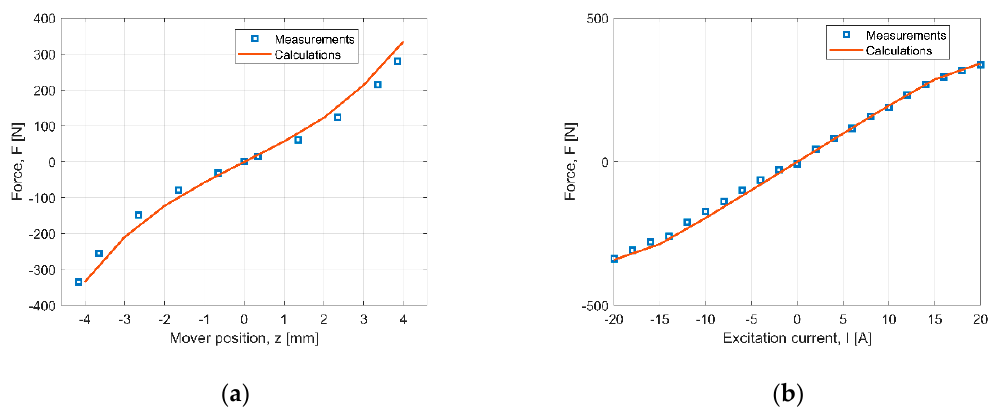
Figure 8. Force verso: ( a ) mover position for I = 0, ( b ) current value for z = 0.